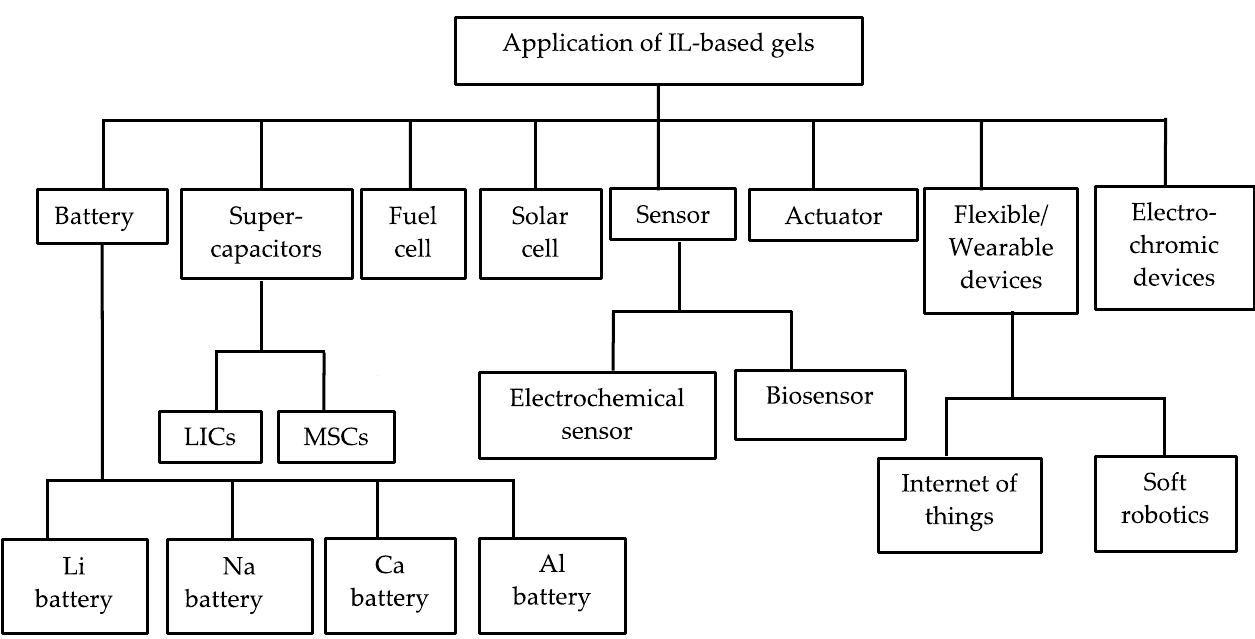
Figure 9. Potential application of IL-based gels in electrochemical devices.